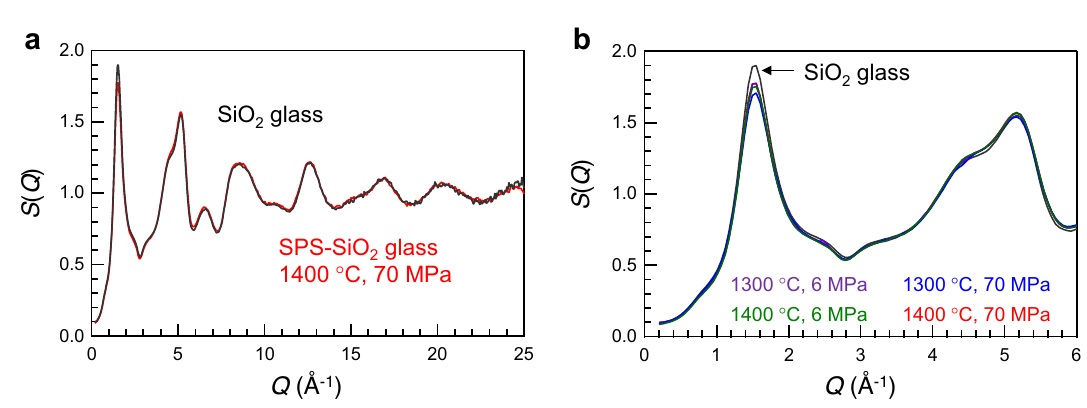
Figure 5. Comparison of S ( Q ) of SPS-SiO 2 glass and SiO 2 glass. ( a ) S ( Q ) of SPS-SiO 2 glass prepared at 70 MPa, 1400 °C along with that of